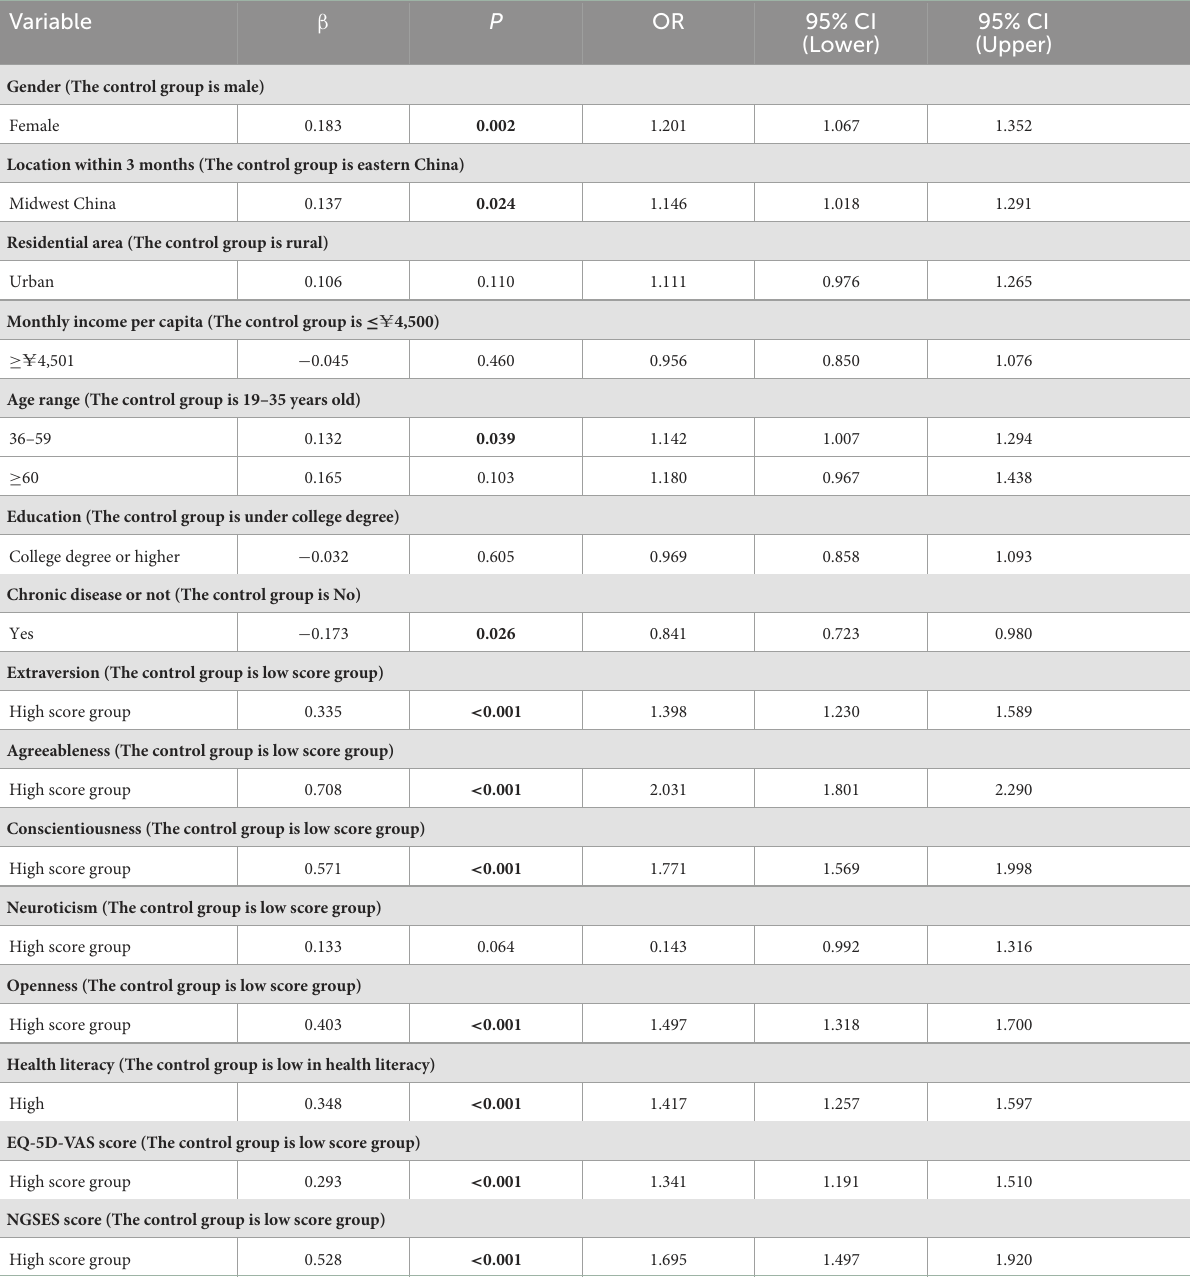
TABLE 6 Single factor analysis for whether survey respondents consider medical staff’s advice as an important factor when purchasing OTC drugs.